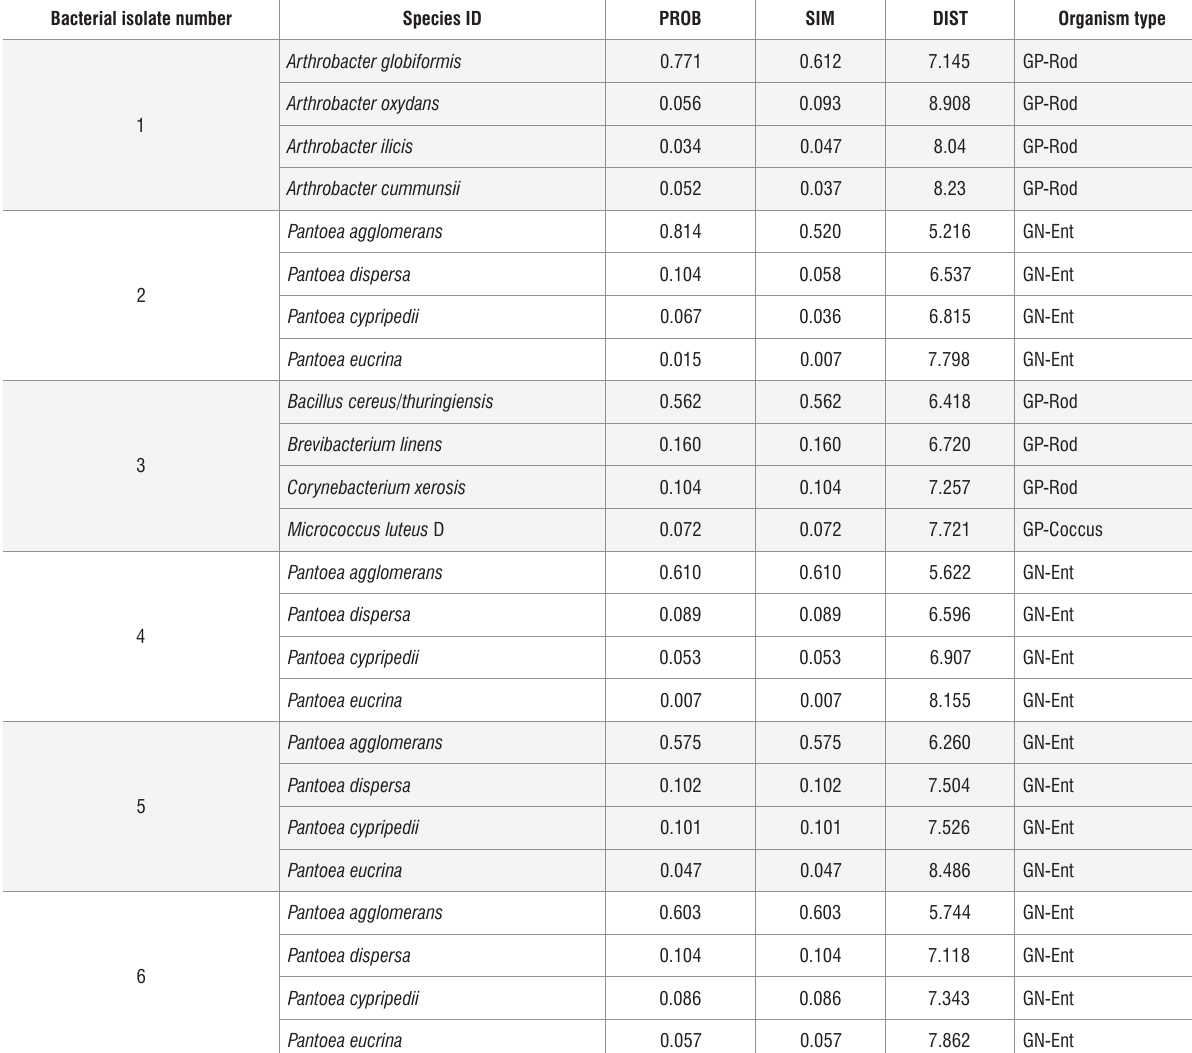
Table 2: Biolog MicroPlate readings of isolated endophytic bacteria Bacterial isolate